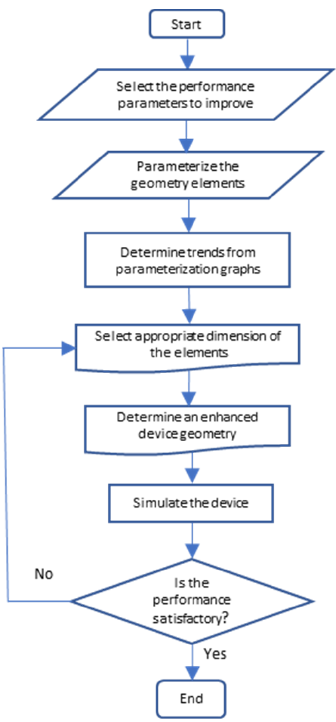
Figure 2. Flux diagram of proposed parameterization process.